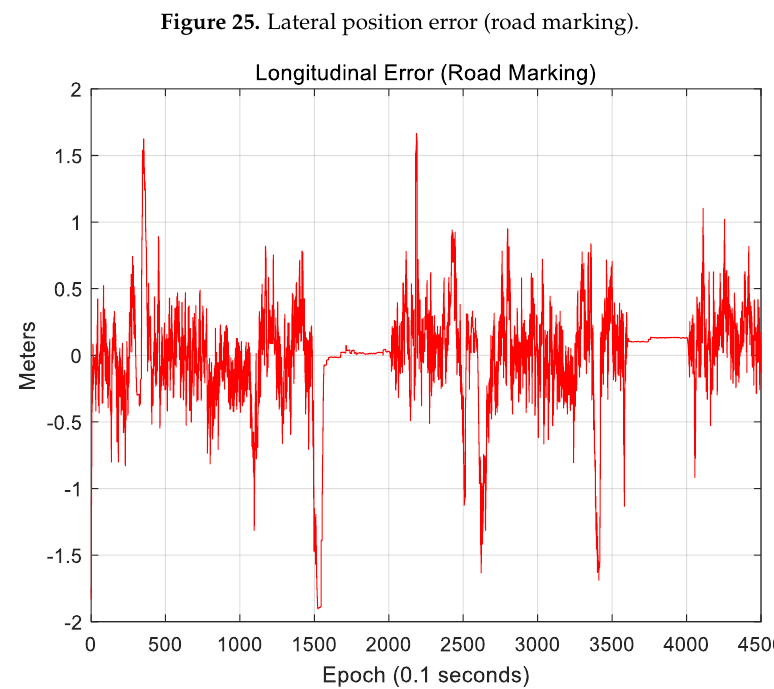
Figure 26. Longitudinal position error (road marking).